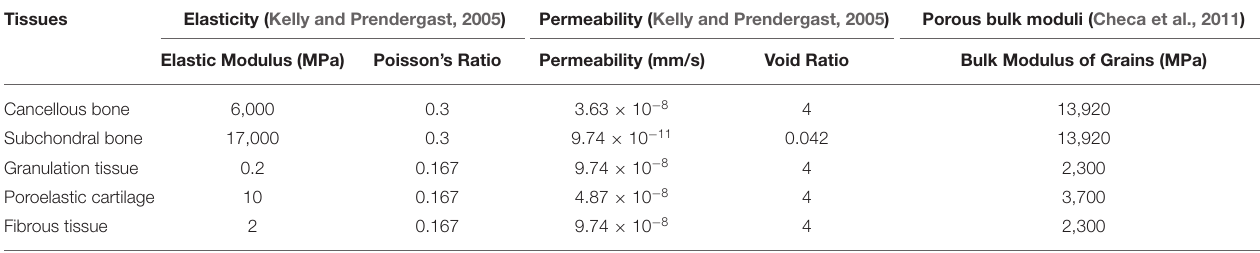
TABLE 1 | Poroelastic material properties of tissues. Tissues